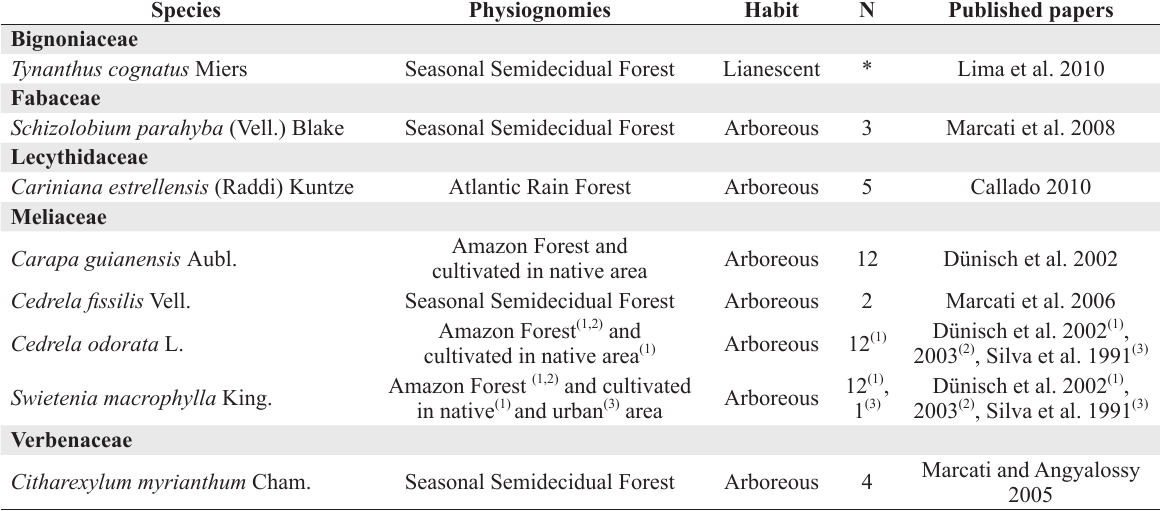
Studied species and physiognomies, habit of the species, number of sampled individuals per species (N), and reference to the published